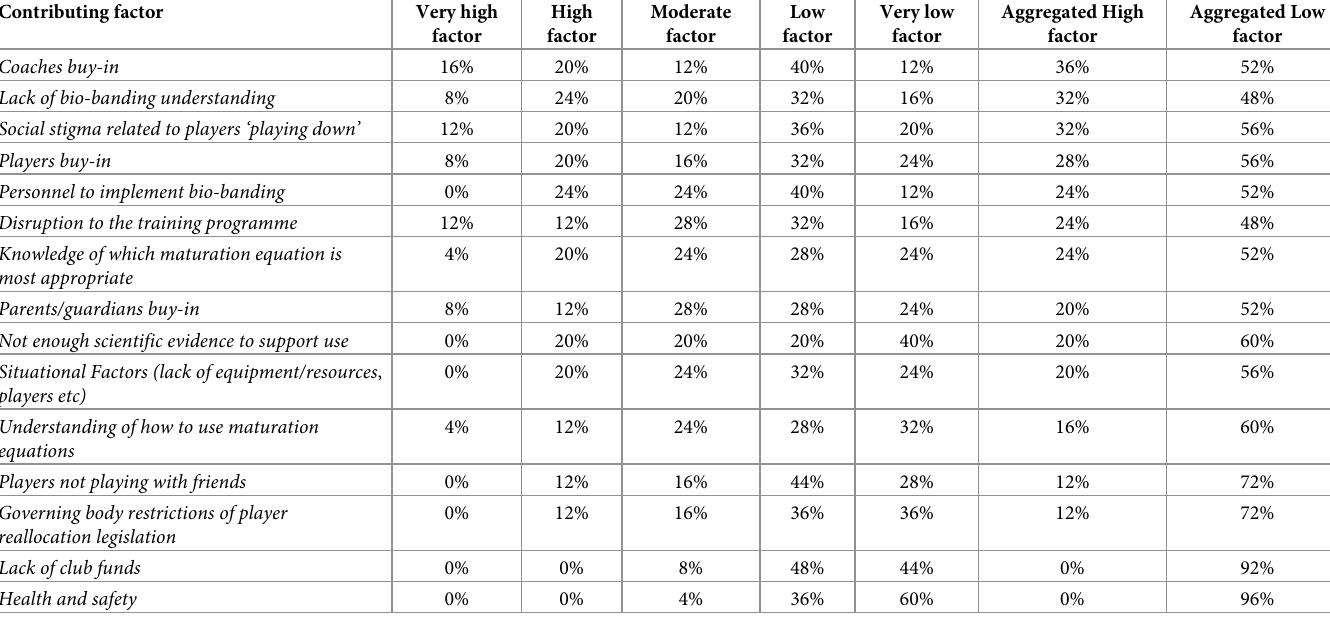
Table 3. Summary table of practitioner individual and aggregated (i.e.,sum of strongly disagree and disagree; sum of strongly agree and agree) perception of con- tributing factors as to why they may not implement